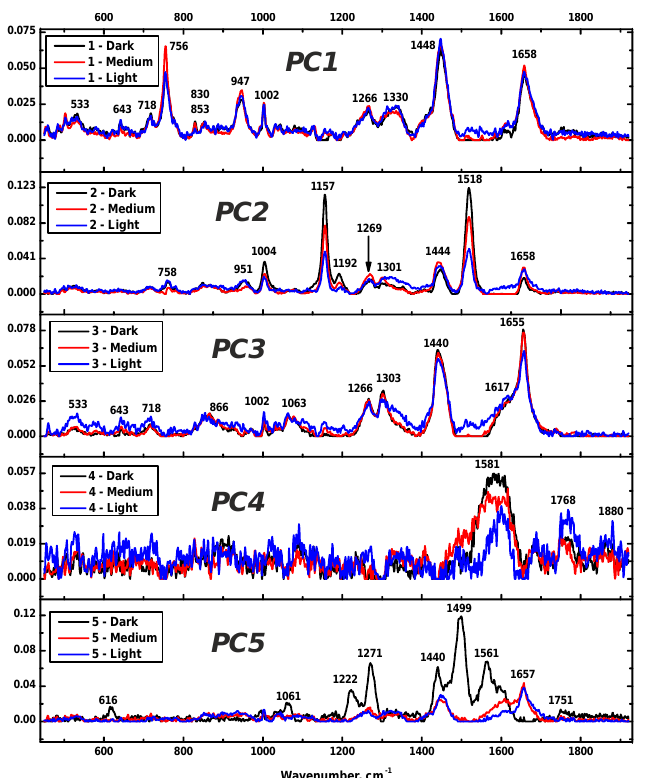
Figure 6. NMF decomposition of Raman spectra. Loadings obtained from spectra spanning the range of 449–1921 cm − 1 . Black, red, and blue lines correspond to dark, medium-coloured, and light spots,